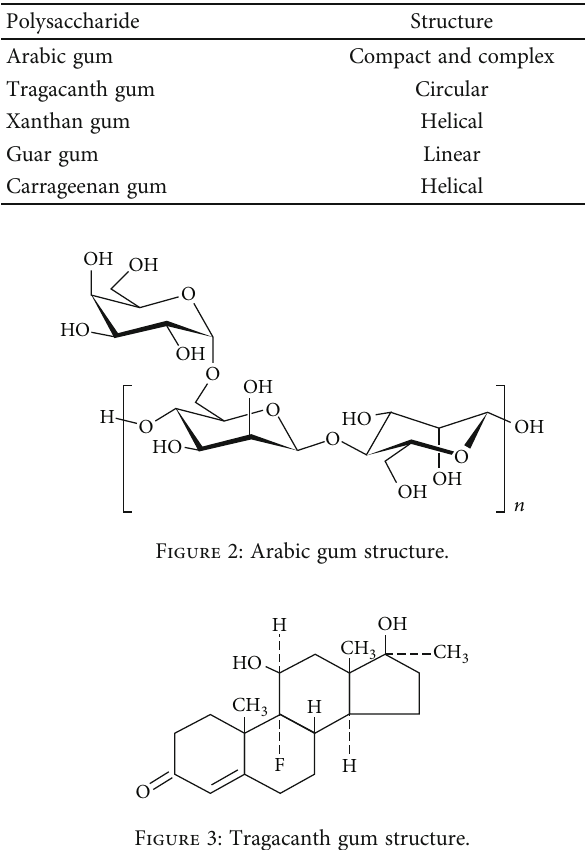
Table 1: Molecular structure and origin of Arabic gum, tragacanth gum, xanthan gum, guar gum, carrageenan gum, and the source.